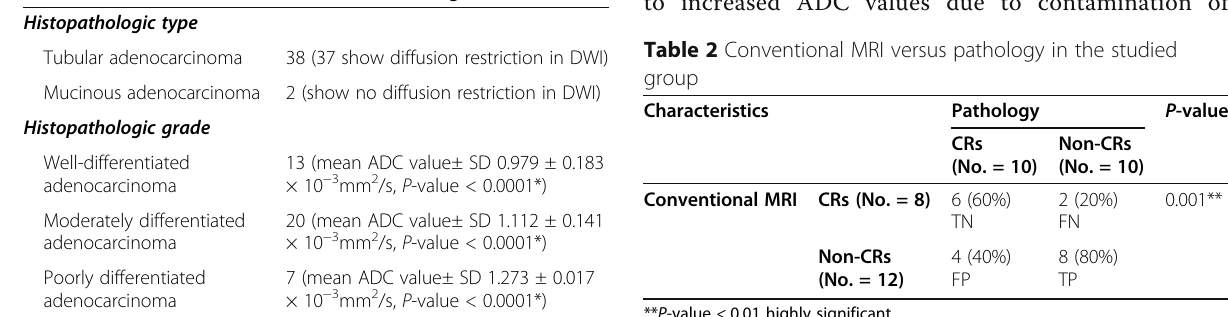
Table 1 Tumor characteristics and MRI findings during initial assessment of the studied 40 patients with colorectal cancer Tumor characteristics